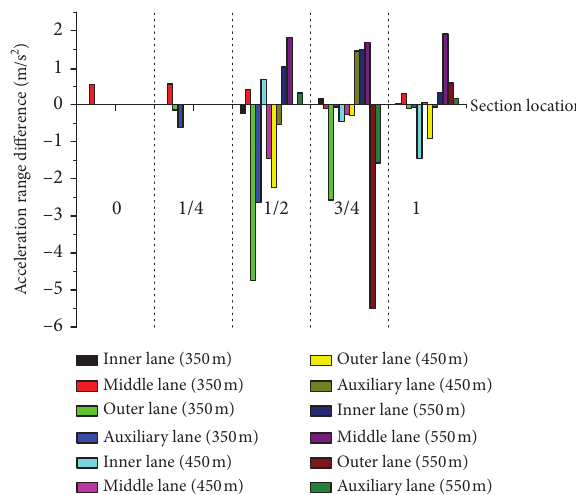
Figure 7: The average speed difference between the optimized method and the original design.